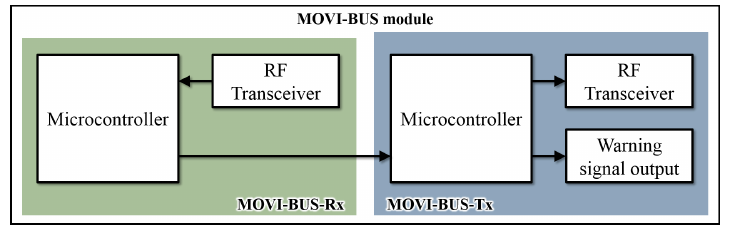
Figure 4. MOVI-BUS block